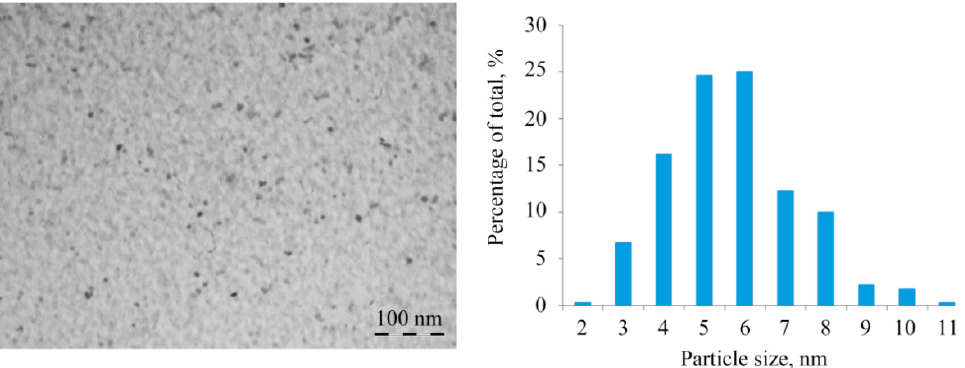
Figure 4. Typical TEM micrograph and size distributions of nanoparticles of Mn-containing NCs for κ -CG-Mn.